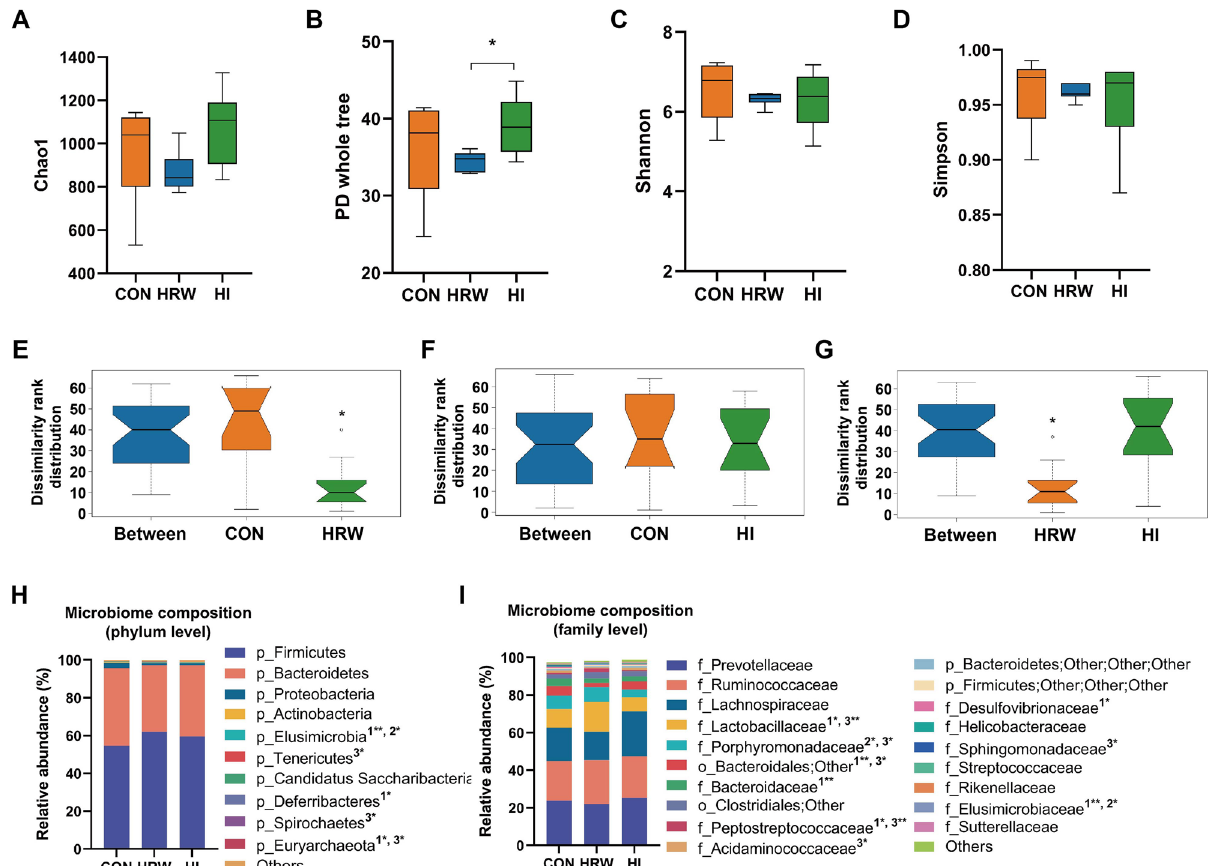
Figure 4. Analysis of bacterial community composition among three groups. ( A – D ) Alpha-diversity of bacterial community was measured by Chao1 ( A ), PD whole tree ( B ), Shannon ( C ), and Simpson ( D ); ( E – G ) ANOSIM was performed to quantitatively compare the bacterial community differences between different groups. ( H , I ) Community bar-plot analysis shows relative abundance of microbiota in each group at the phylum level ( H ) and family level ( I ), n = 6, in each